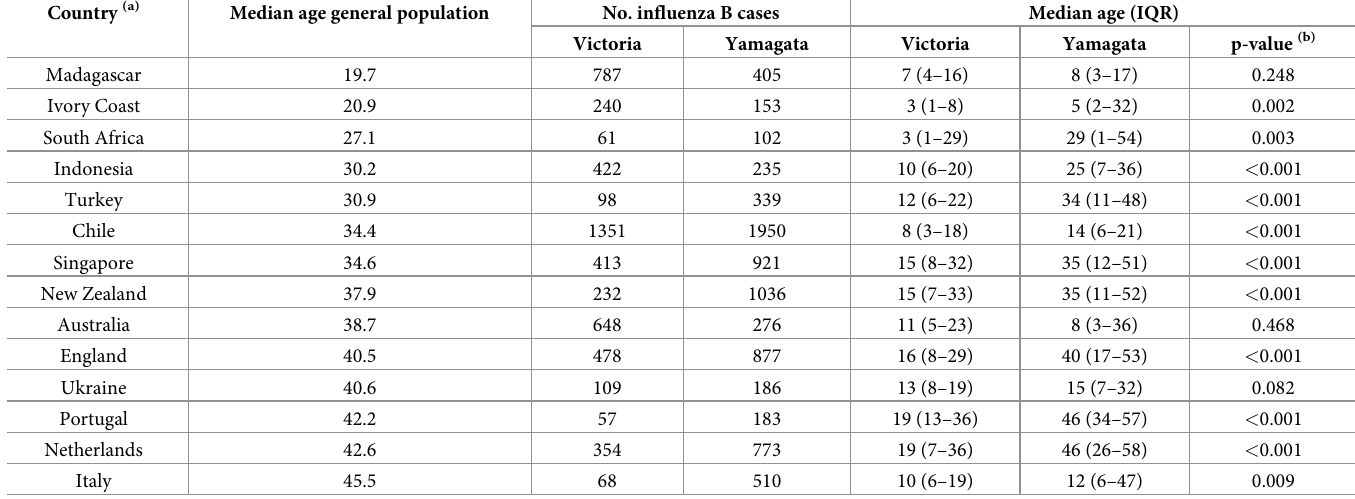
Table 2. Age distribution of influenza B/Victoria and B/Yamagata patients by country (sorted by median age of the general population). The Global Influenza B Study, 2000–2018. Country